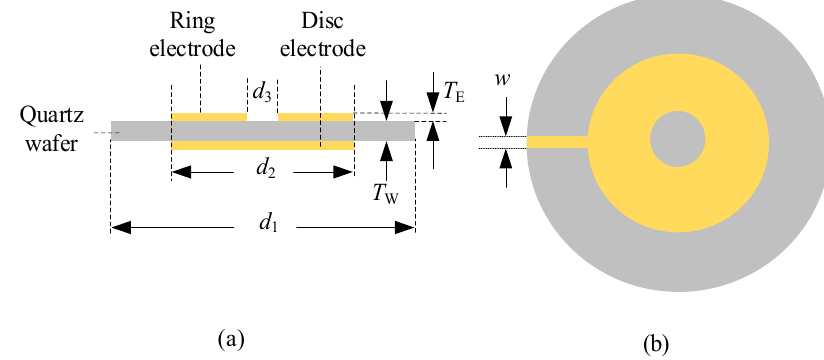
Figure 1. Structure of R-QCM. ( a ) Side view; ( b ) top view.